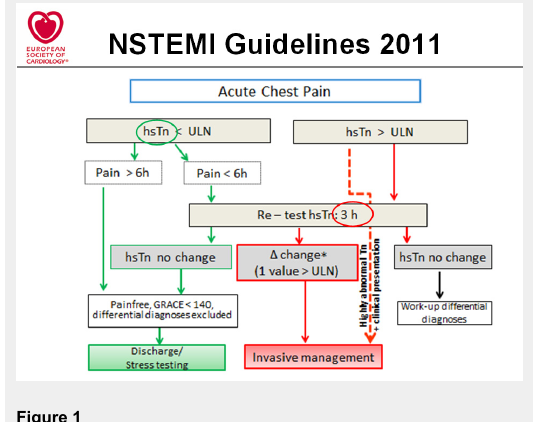
ESC 2011 rapid rule-out algorithm using hs-cTn levels (adapted from [1]; © European Heart Journal, reprinted with